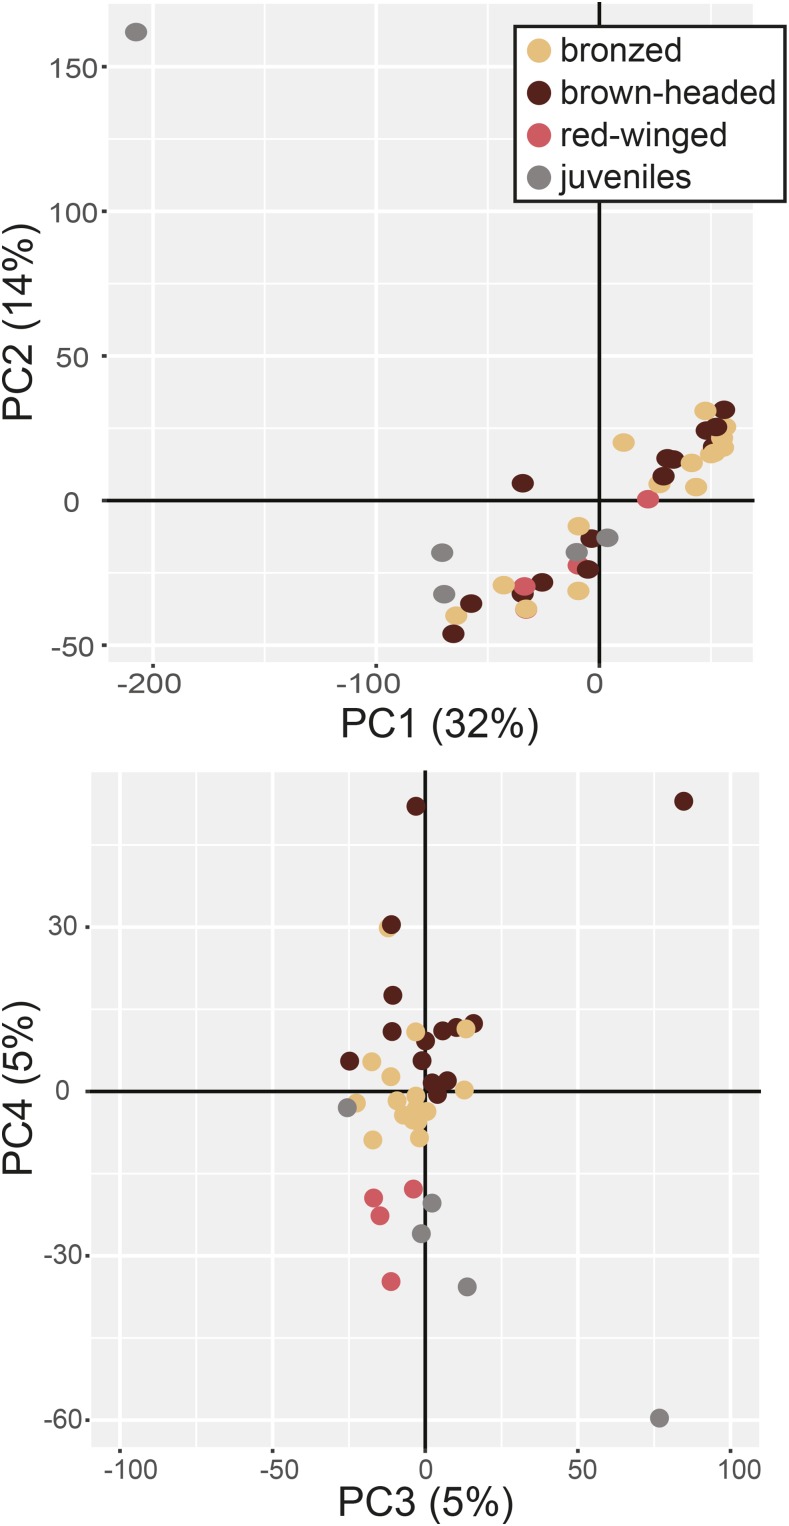
Principal components analysis of expression in all transcripts (12,237 orthologous) across all samples. Principal component 1 (PC1) explained 32% of the overall variation in gene expression and significantly separated adult parasitic bronze cowbirds (tan) and brown-headed cowbirds (brown) from juvenile (gray), but not adult (red), non-parasitic red-winged blackbirds. PC2 explained 14% of the overall variance in gene expression but was not associated with any experimental variables. PC3 and PC4 each explained 5% of the overall variance. While variation in PC3 was not associated with any experimental variables, PC4 separated parasitic bronzed and brown-headed cowbirds from non-parasitic red-winged blackbirds.